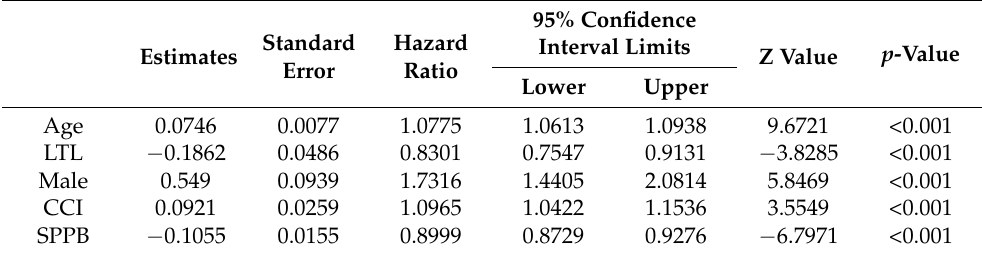
Figure 4. Graphic comparison of the survival of the 4 groups/quartiles. Survival curves were estimated using Kaplan–Meier method. From the group with the shortest LTL to the one with the longest LTL, the median survival time is, respectively, 4.67, 5.87, 6.73 and 8.79 years. Table 4. Determinants of survival. Estimated semi-parametric Cox’s proportional hazards model for survival